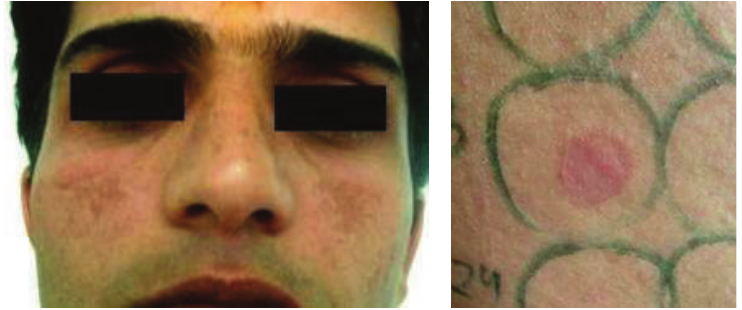
Figure 7: Positive patch test from sorbic acid in a patient with malar pattern of